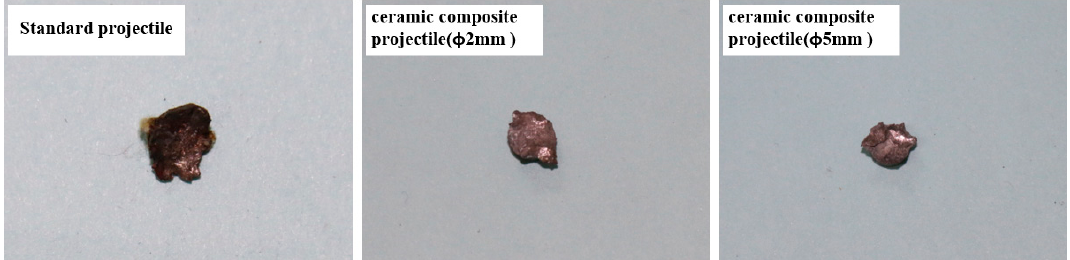
Figure 13. Ceramic/Kevlar composite armor target fragments.